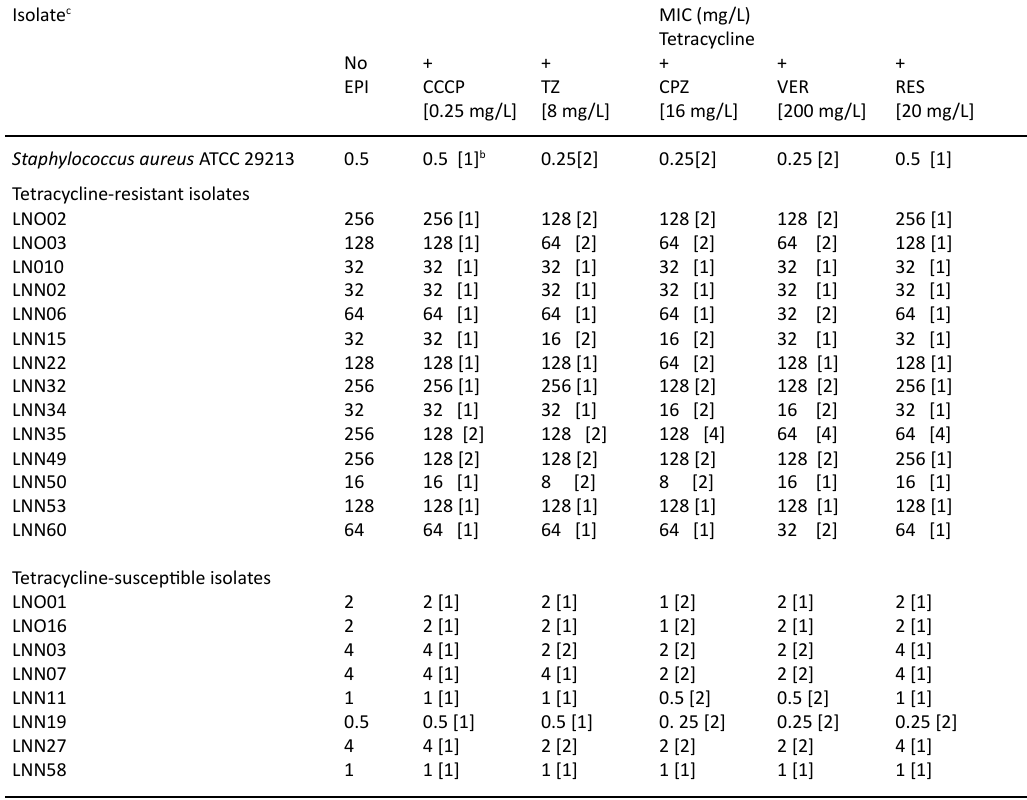
table s3. Effects of Efflux pump inhibitors on tetracycline resistance on MRSA isolates in KZN Isolate c